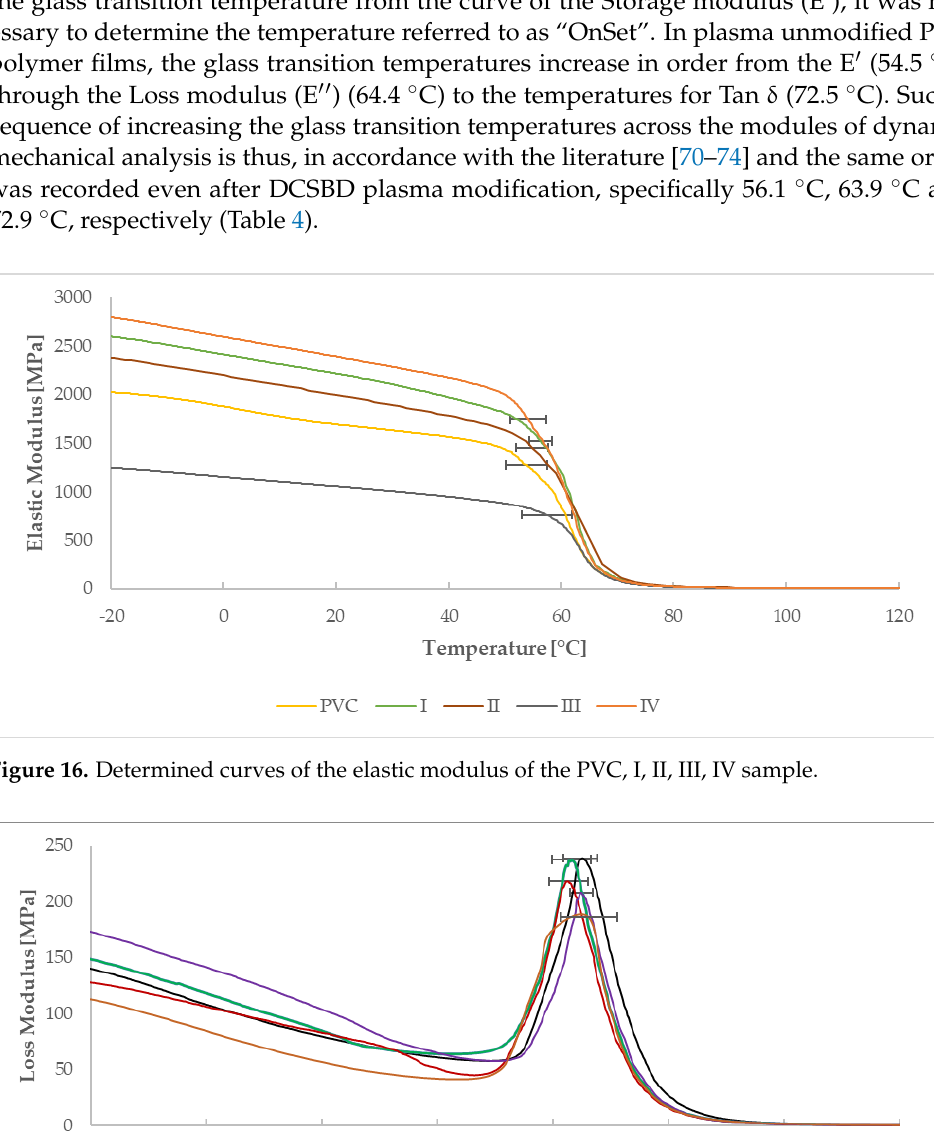
Figure 18. Determined Tan Delta curves of PVC samples, I, II, III, IV.